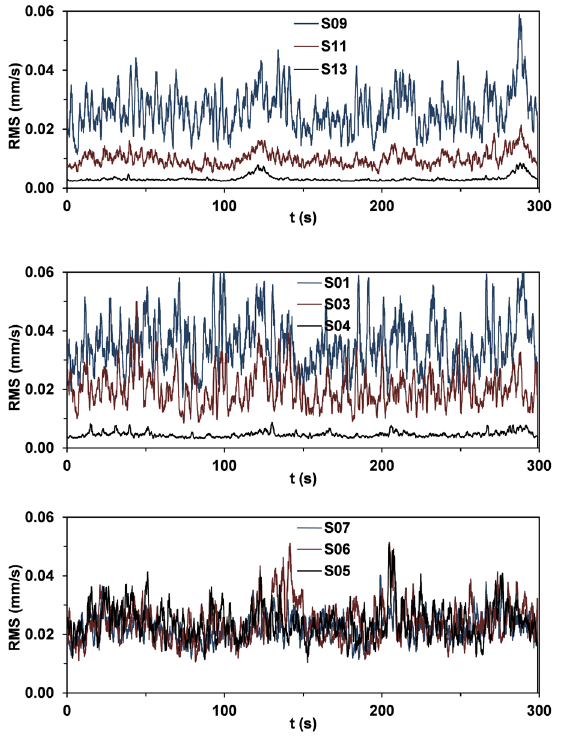
Figure 7. RMSs of recording velocities in configuration C1.